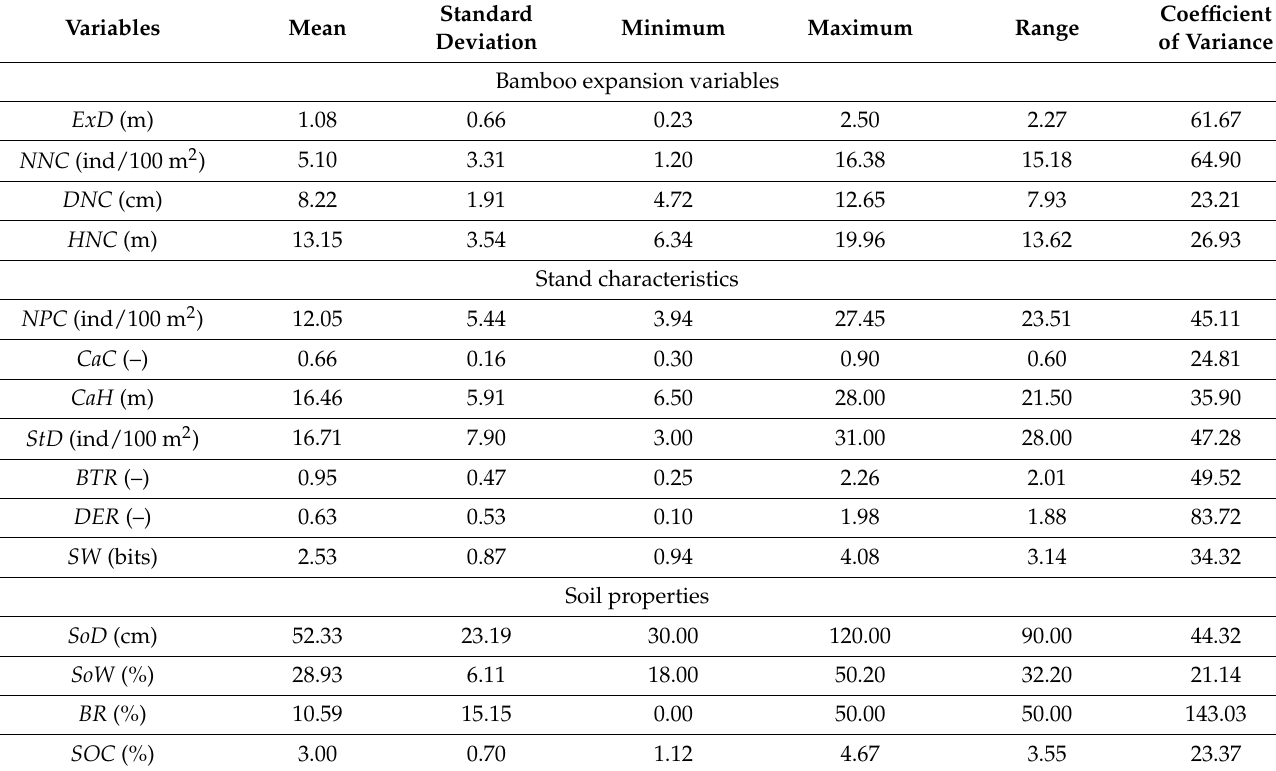
Table 2. The statistics for the variables of bamboo expansion, stand characteristic and soil properties at 58 bamboo–woodland interface plots in Jiangxi province,